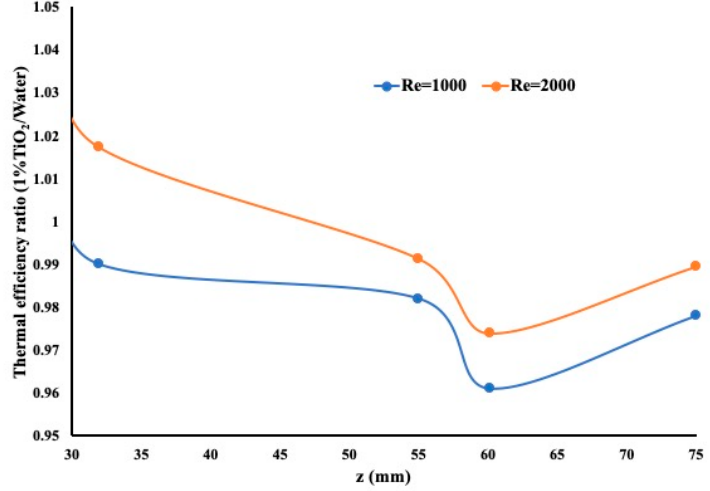
Figure 12. Thermal efficiency ratio between nanofluid and water (twisted tape inserts).